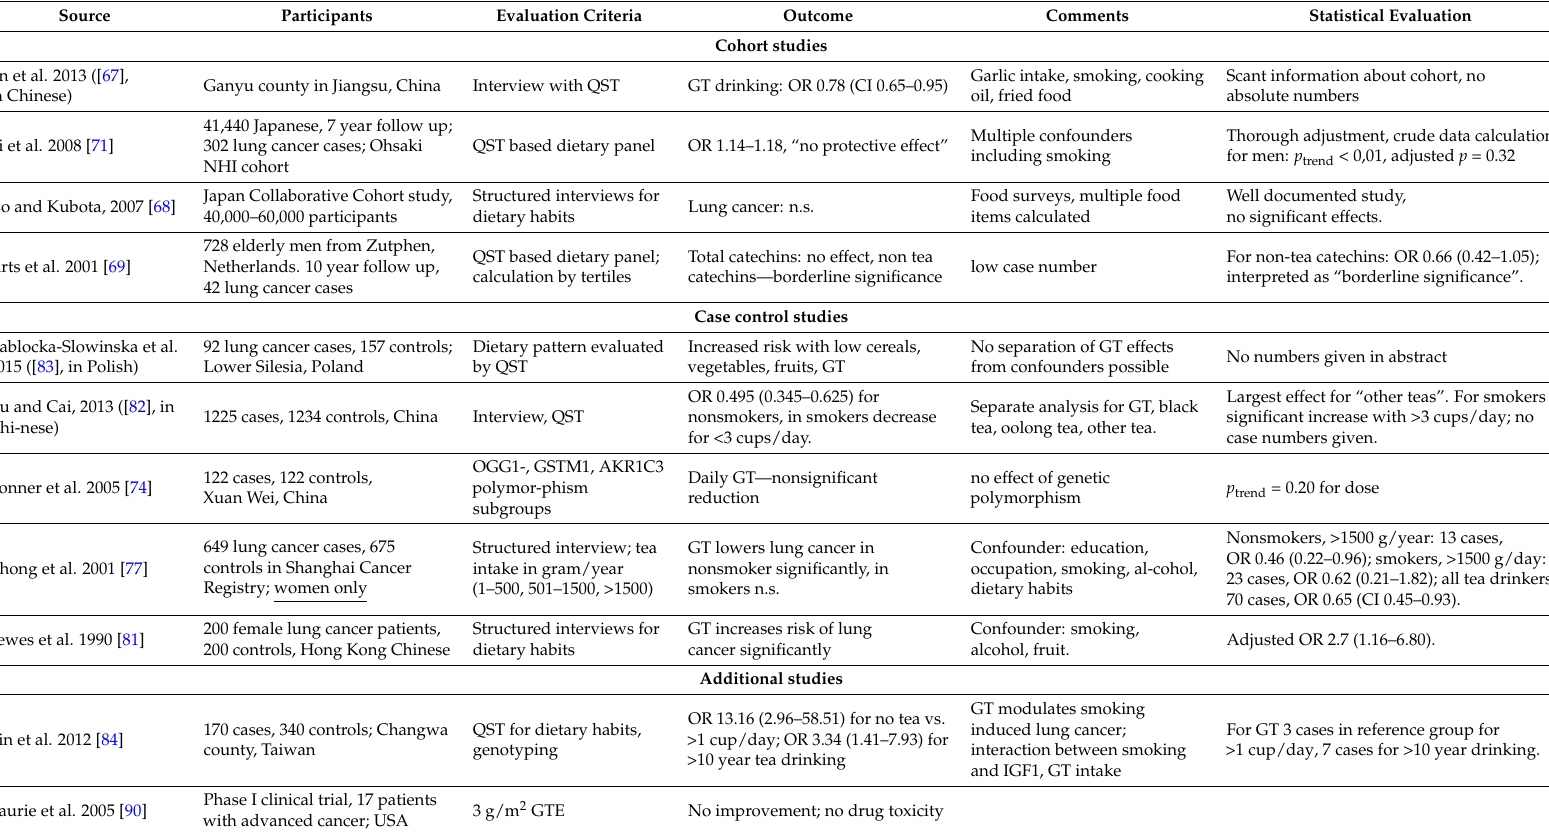
Table 1. Evidence for green tea (GT) or green tea extracts (GTE) protection against lung